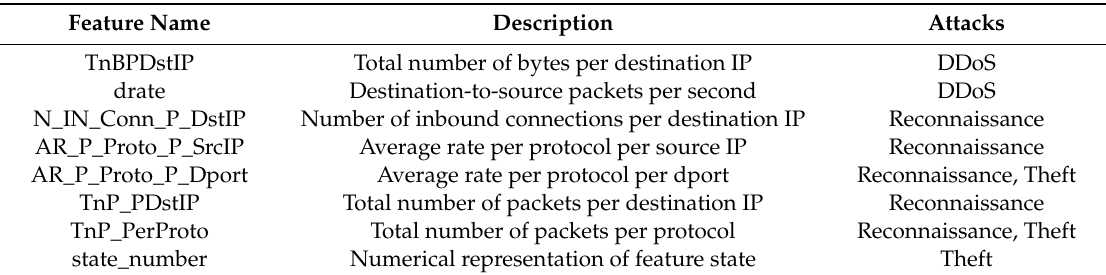
Table 2. Selected features by correlated-set thresholding on gain-ratio (CST-GR) for each kind of